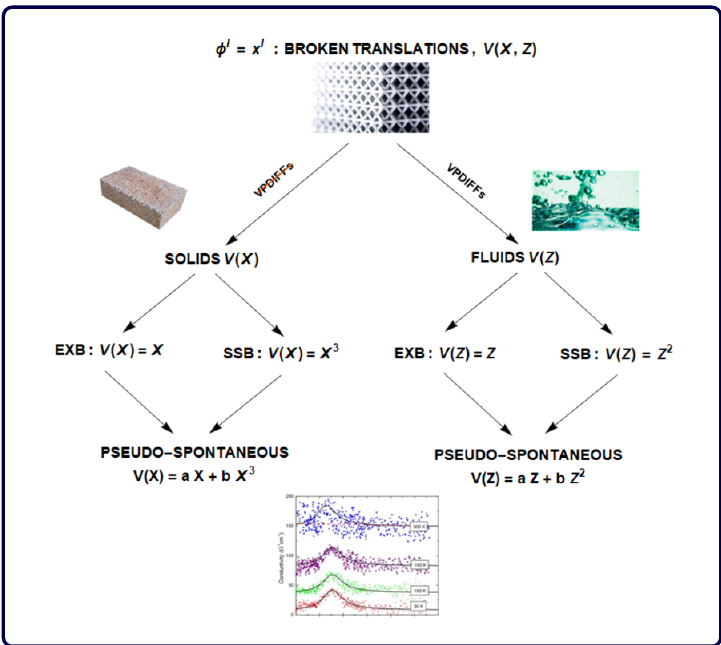
Figure 25 . A schematic diagram of all the holographic massive gravity models with broken trans- lations. The right branch of this diagram have been completed in this